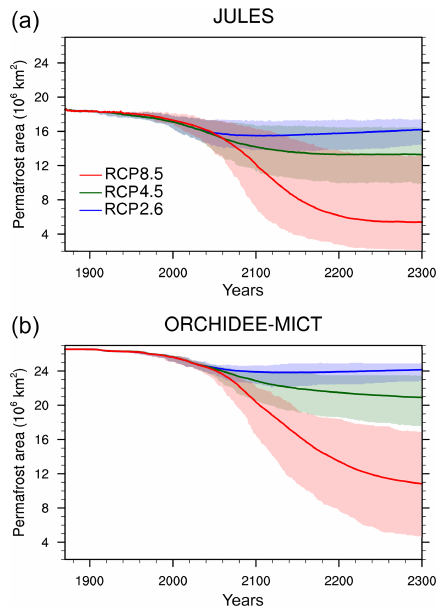
Figure 4. The areal change in simulated permafrost area extent for the JULES and ORCHIDEE-MICT models, and for three differ- ent RCP scenarios. The shaded areas in this and subsequent figures represent the full ensemble spread, accounting for uncertainty in climate response across GCMs